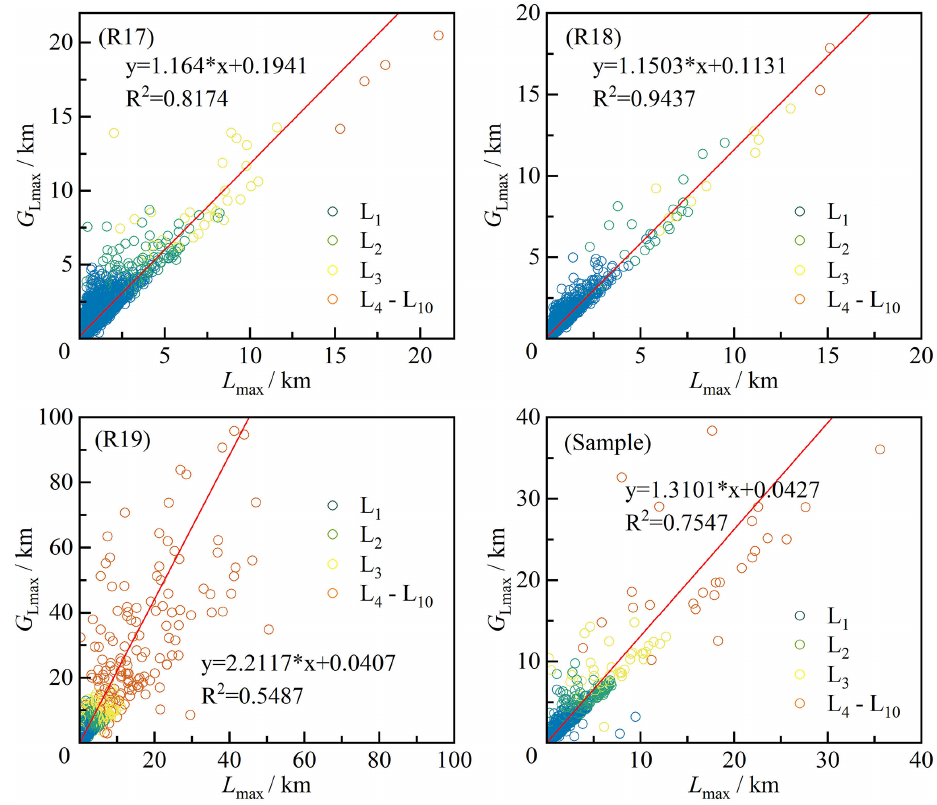
Figure B1. Linear regressions for different glacier regions between the glacier length ( G Lmax ) calculated in this study and the glacier length ( L max ) calculated by Machguth and Huss